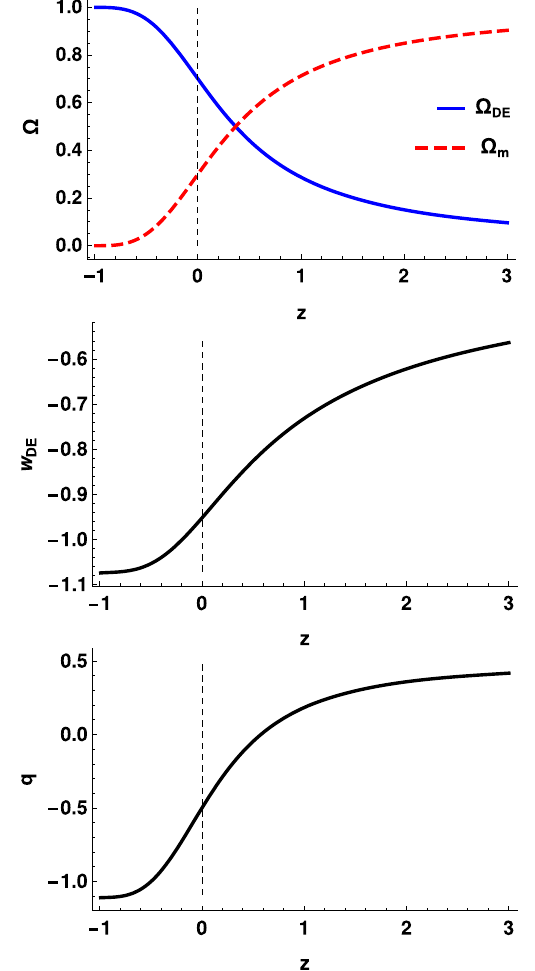
Fig. 1 Upper graph: the Kaniadakis holographic dark energy density parameter (cid:8) DE (blue-solid) and the matter density parameter (cid:8) m (red- dashed), as a function of the redshift z , for K = 0 . 1 and c = 0 . 9. Middle graph: the corresponding dark-energy equation-of-state param- eter w DE . Lower graph: the corresponding deceleration parameter q . In all graphs we have set (cid:8) DE ( x = − ln ( 1 + z ) = 0 ) ≡ (cid:8) DE 0 ≈ 0 . 7 in agreement with observations, and for convenience we have added a vertical dotted line marking the present time z =